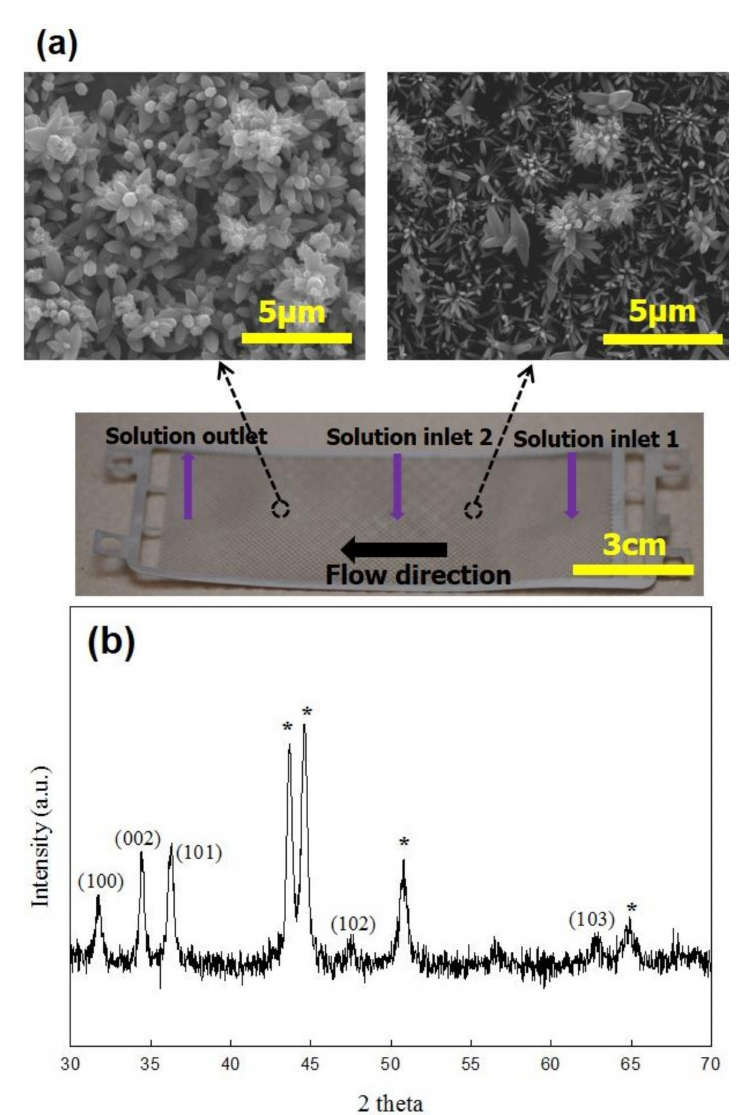
Figure 4. ( a ) SEM images of ZnO nanostructures grown on the wick structure and photograph of the coated wick structure; ( b ) X-ray diffraction pattern of the coated wick structure (* denotes stainless steel peaks from bare wick